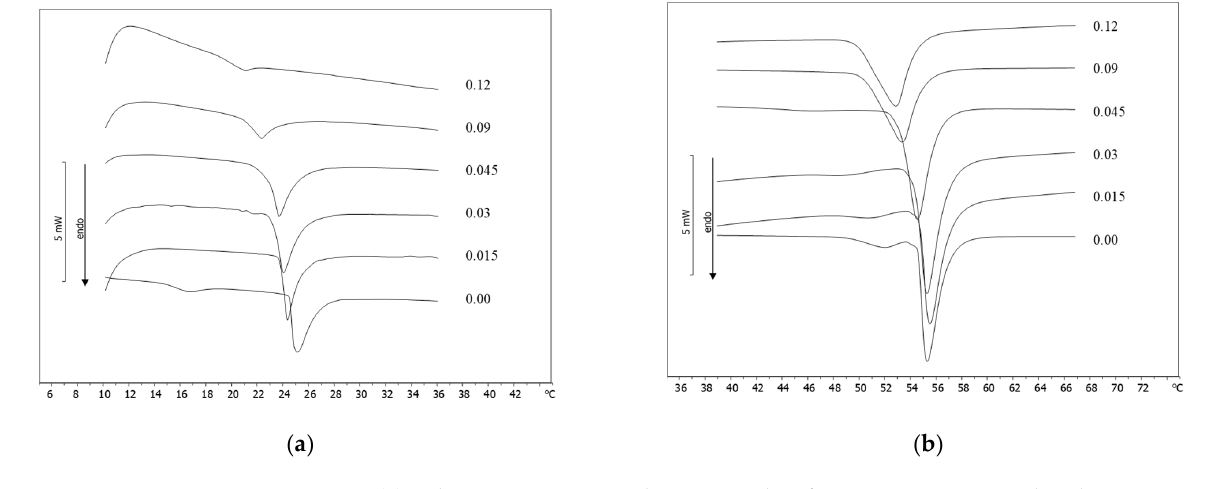
Figure 1. ( a ) Calorimetric curves, in heating mode, of DMPC MLV prepared with increasing molar fractions of PCAEE; ( b ) Calorimetric curves, in heating mode, of DSPC MLV prepared with increasing molar fractions of PCAEE.